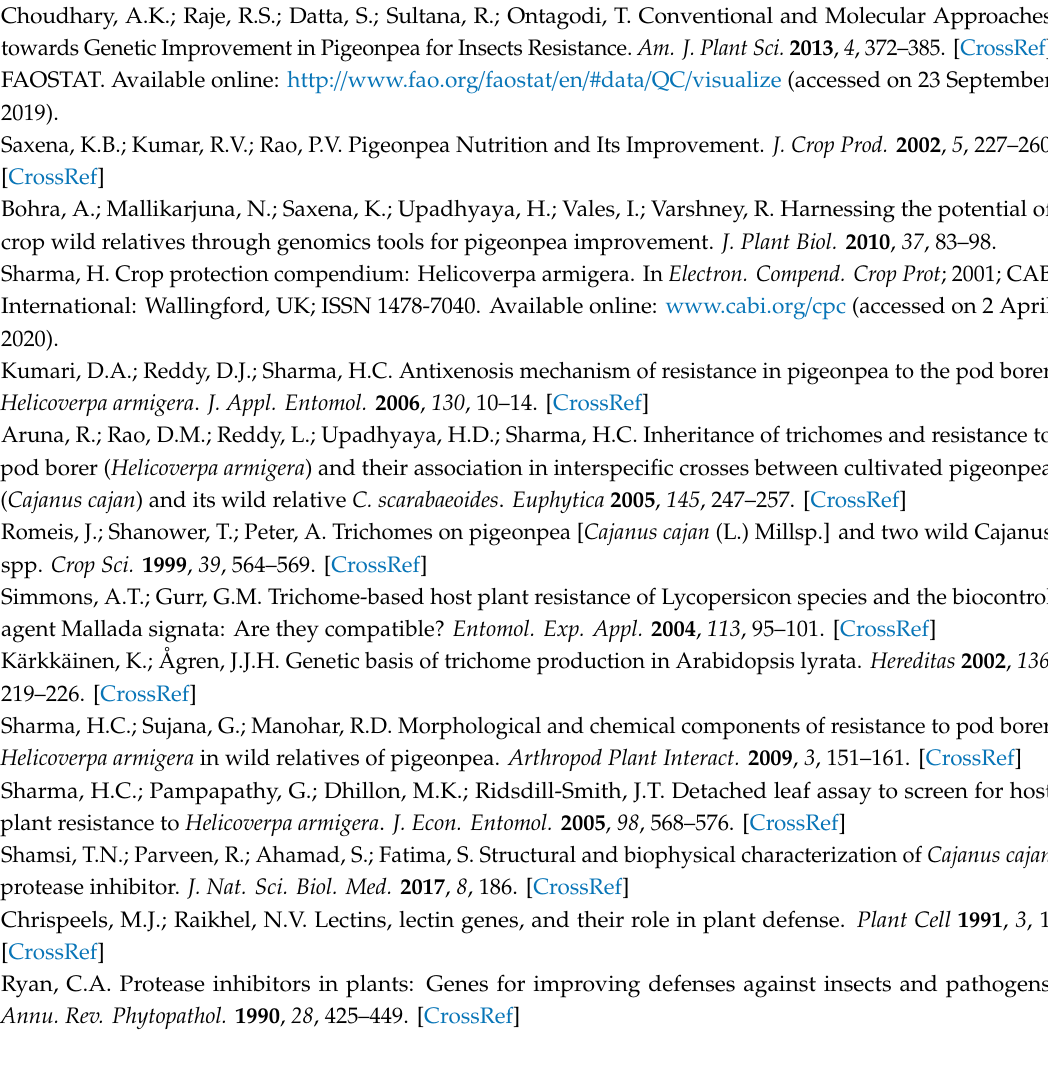
C. cajan , using non-heated (green bars) and heated (red bars) artificial diet supplemented with lyophilised leaf powder. Table S2. Mineral and protein composition of raw mature pigeonpea seeds. Table S3. Summary of protein abundance for cysteine proteinase inhibitor and lectin-domain containing receptor kinase A4.2 in Cajanus cajan (ICPL 87) and Cajanus scarabaeoides (IBS 3471)